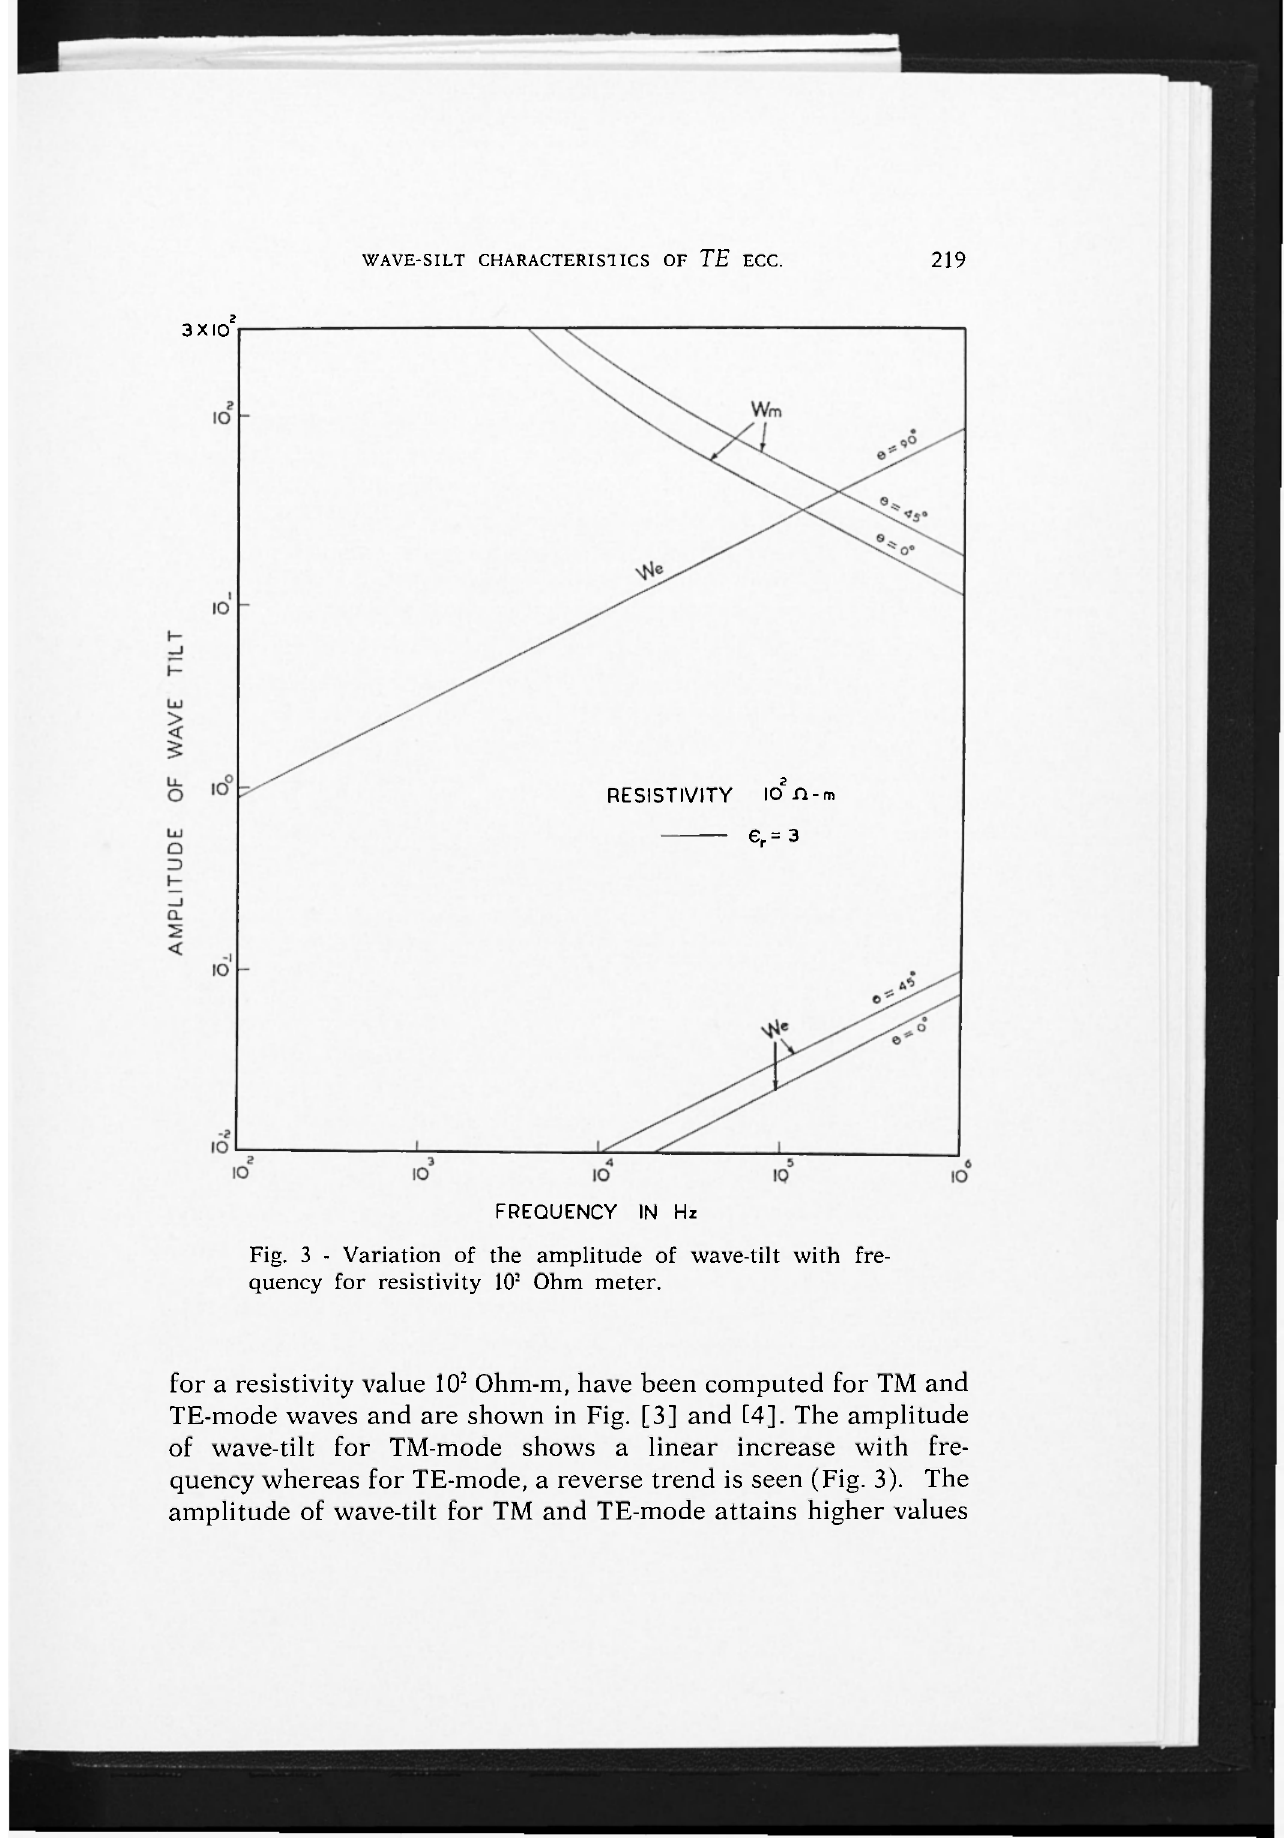
WAVE-SILT CHARACTERISTICS OF TE